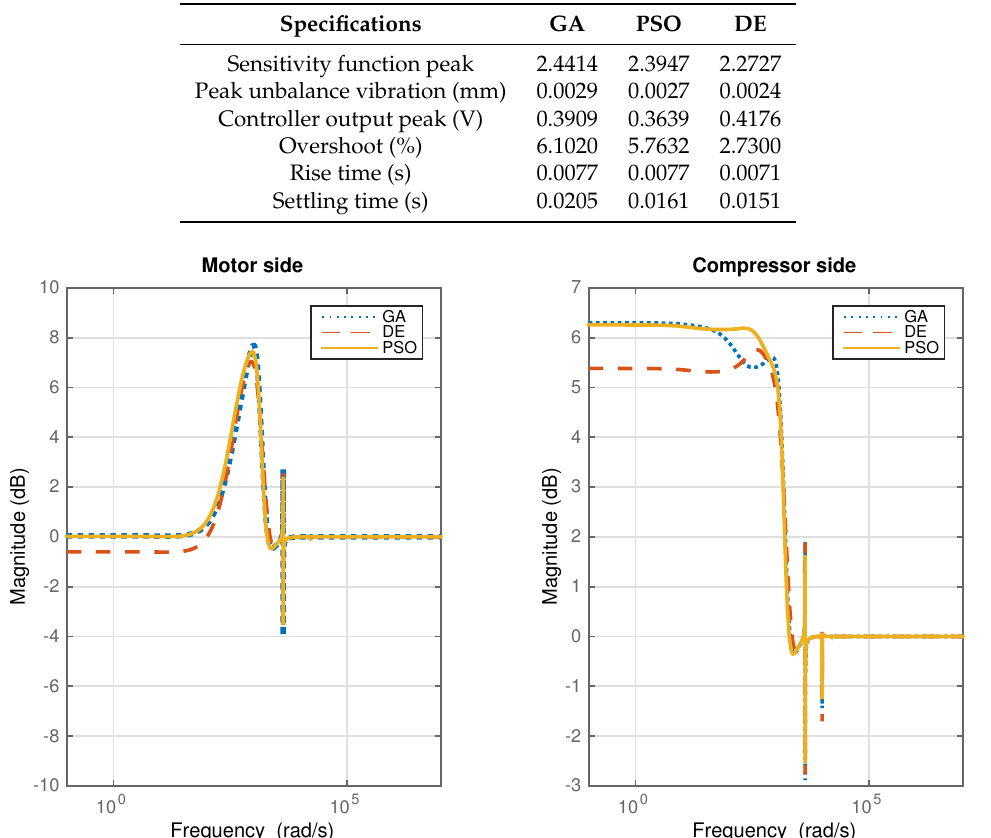
Figure 19. Magnitude plots of the sensitivity functions of the FOPID controllers with different tuning